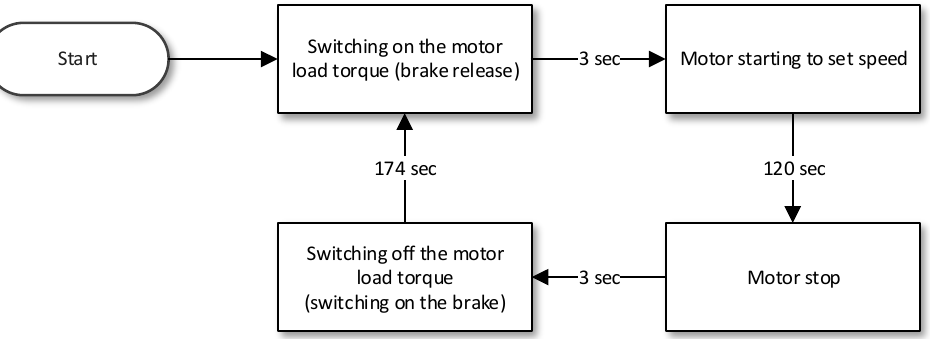
Figure 13. The dynamometer control algorithm emulating the activation of the mechanical brake after motor stopping.